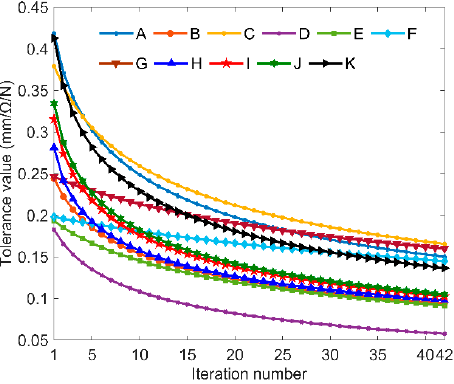
Figure 11. Variation of tolerance values. Table 4. Tolerance values of variables before and after robust design optimization.